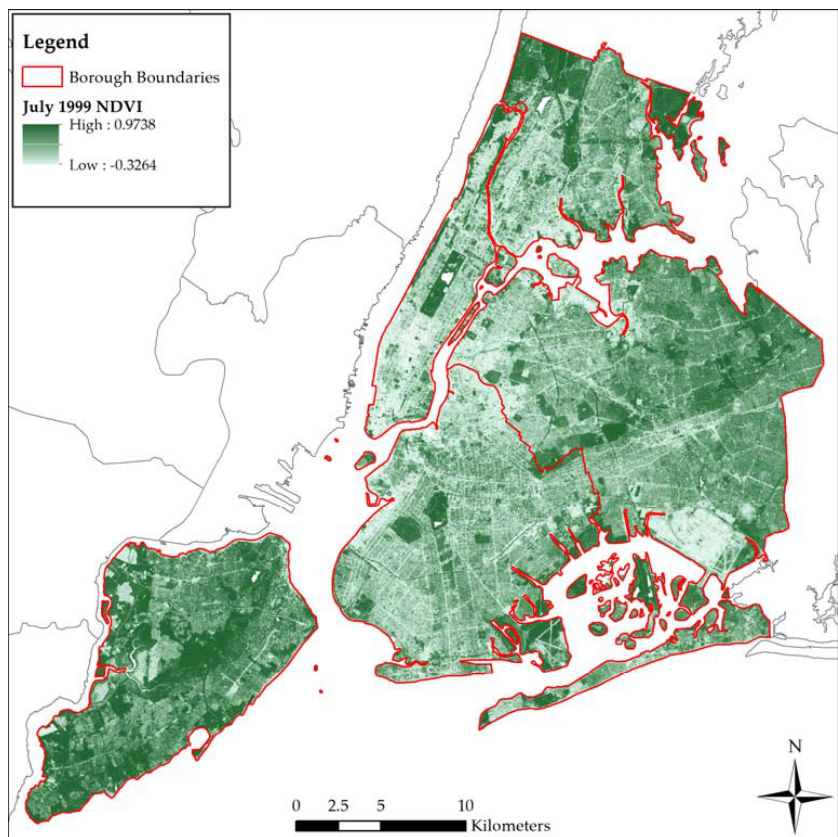
Figure 1. Distribution of Normalized Difference Vegetation Index (NDVI) values in New York City.